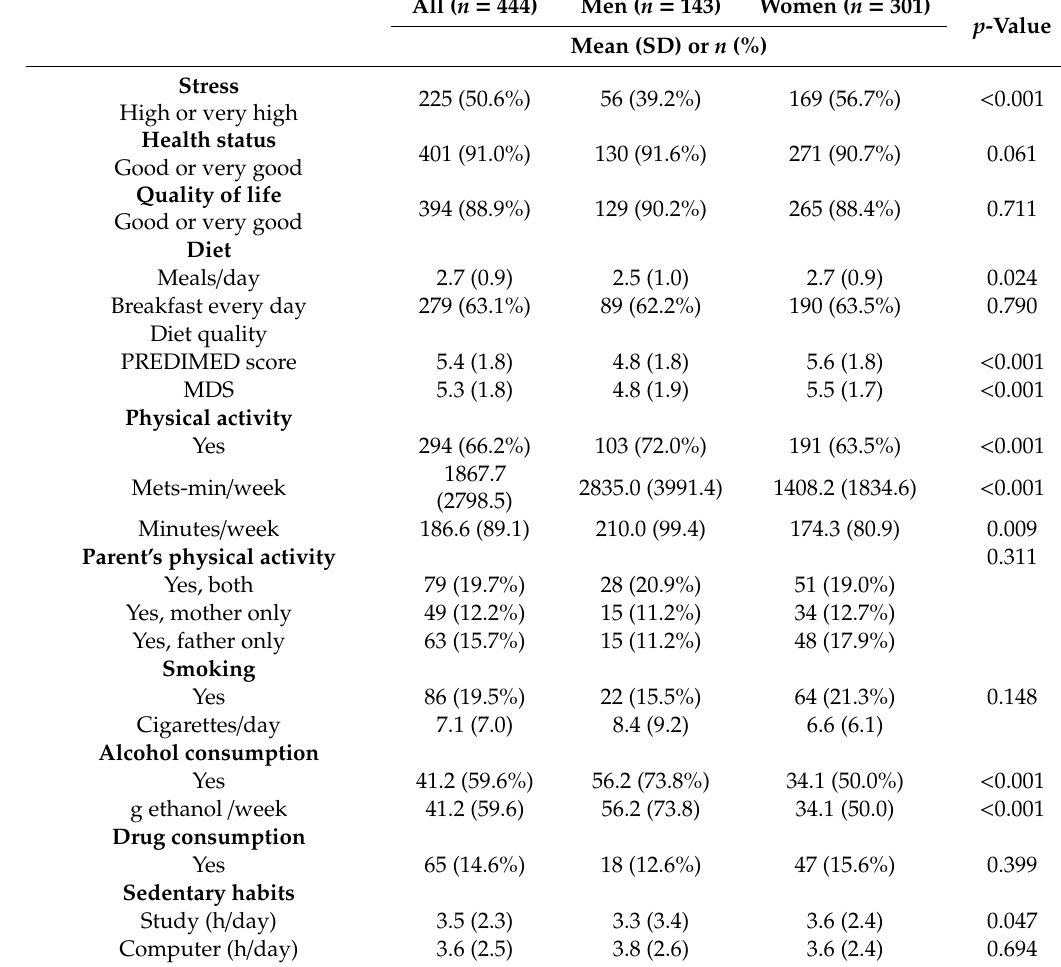
Table 2. Health-related behaviors of participants ( n =